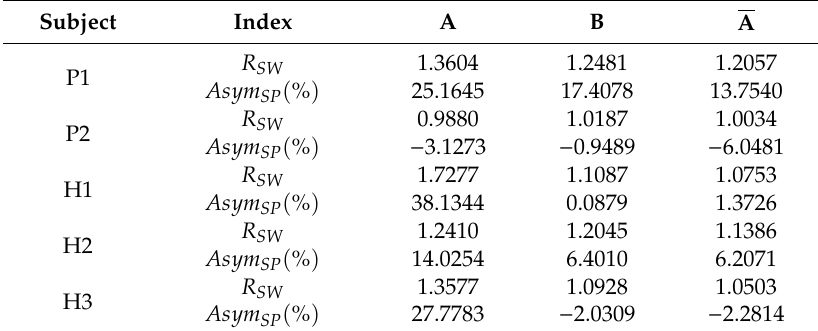
Table 6. Performance analyses of Figure